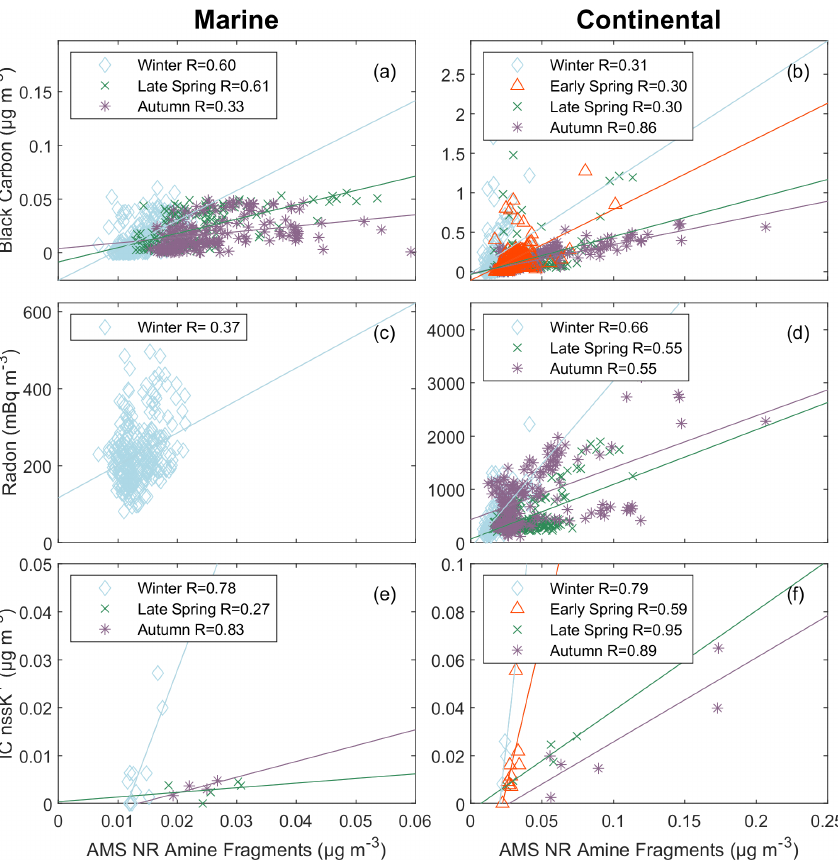
Figure 6. Scatterplot of nonmarine tracers versus AMS NR amine fragments for marine periods (a, c, e) and continental periods (b, d, f) . The panels include black carbon (a, b) , radon (c, d) , and IC nssK + (e, f) . Markers represent each cruise: blue open diamond – winter, green cross – late spring, purple asterisk – autumn, and red open triangle – early spring. The solid lines are the lines of best fit obtained using an ordinary least squares regression for R | ≥ 0 .